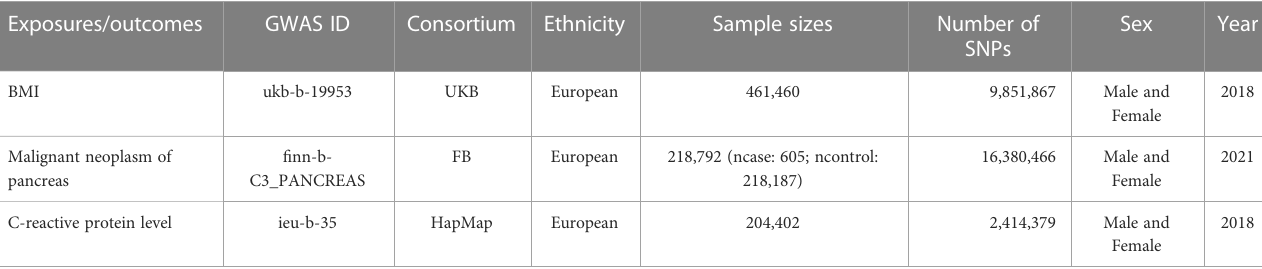
TABLE 1 Summary of the GWAS included in this MR study neoplasms.